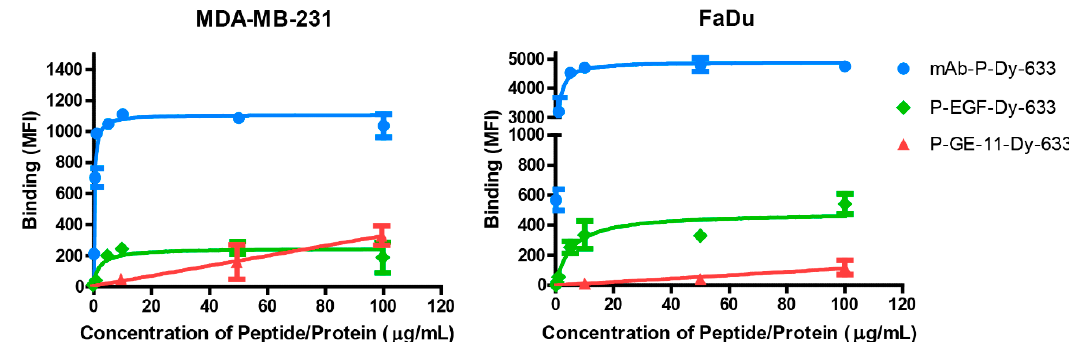
Figure 2. Binding of mAb-P-Dy-633 , P-EGF-Dy-633 and P-GE11-Dy-633 conjugates to EGFR expressed in MDA-MB-231 and FaDu cells. Each datapoint represents the mean ± SEM of at least two experiments performed in duplicate (SEM showed after reaching value > 50 MFI).